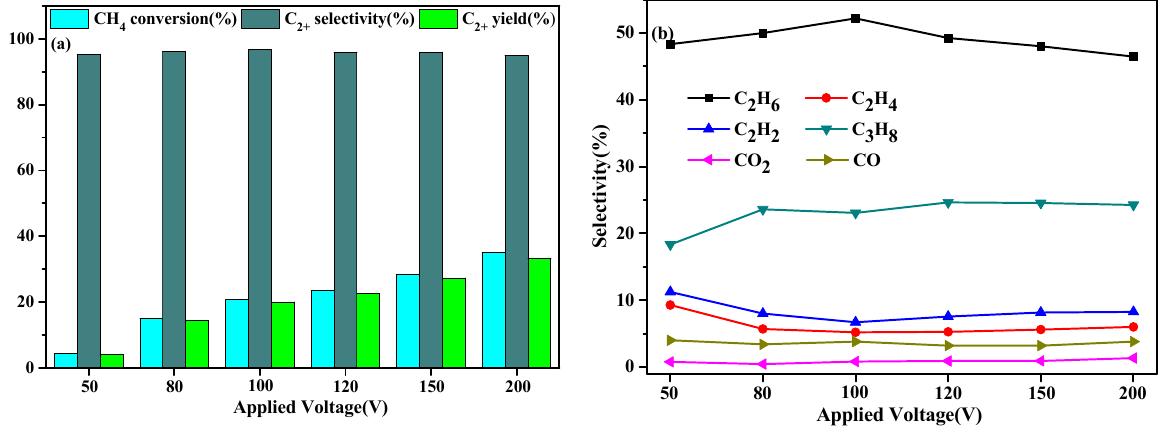
Figure 7. Effect of applied voltage on the catalytic performance of the MnTi catalyst in DBD plasma. ( a ) Oxidative coupling performance; ( b ) product distribution (temperature: ambient temperature, flow rate: 60 mL/min).